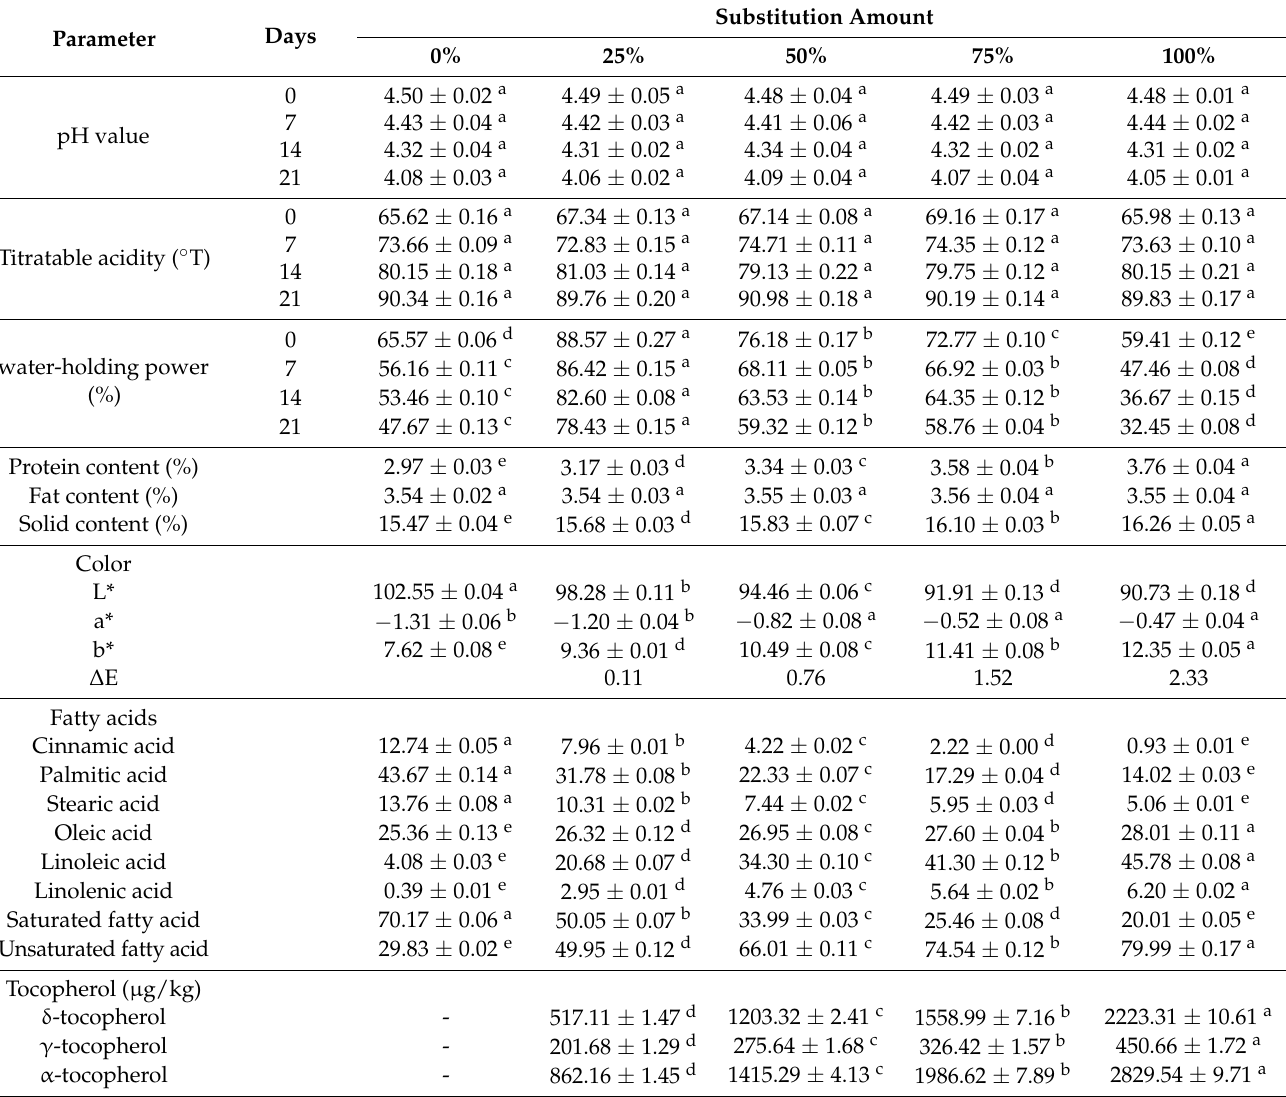
Table 1. Physicochemical properties of yogurt with different substitution amounts of SOBs replacing milk